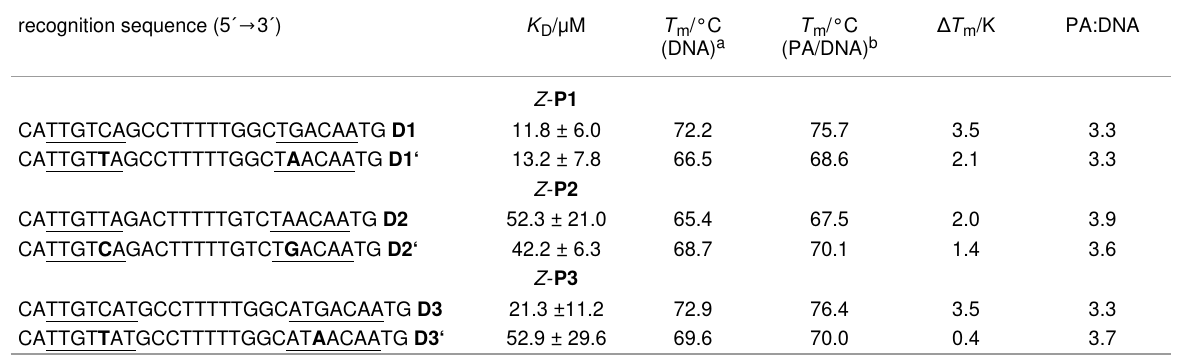
Table 1: Binding constants and melting temperatures of the interaction of the polyamides with dsDNA obtained by circular dichroism. recognition sequence (5´ →